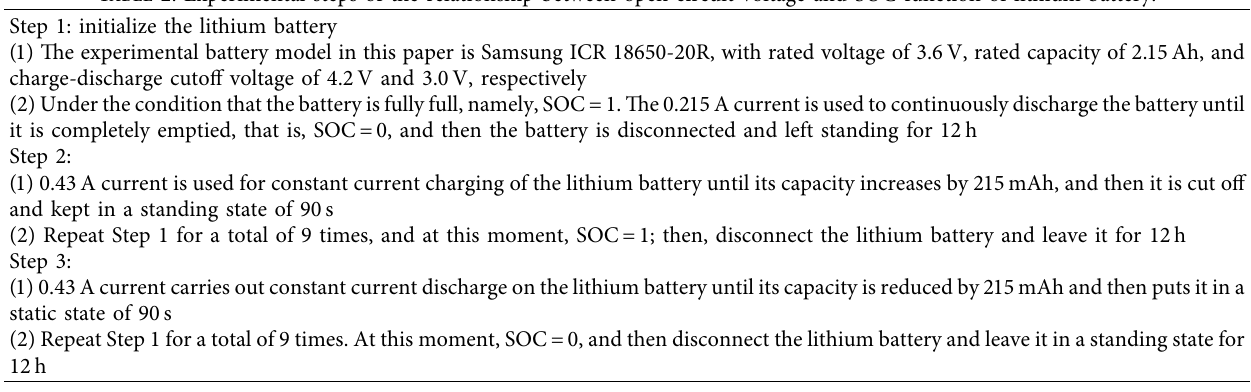
Figure 5: The relationship between SOC and OCV in supercapacitor. Table 2: Experimental steps of the relationship between open circuit voltage and SOC function of lithium battery.